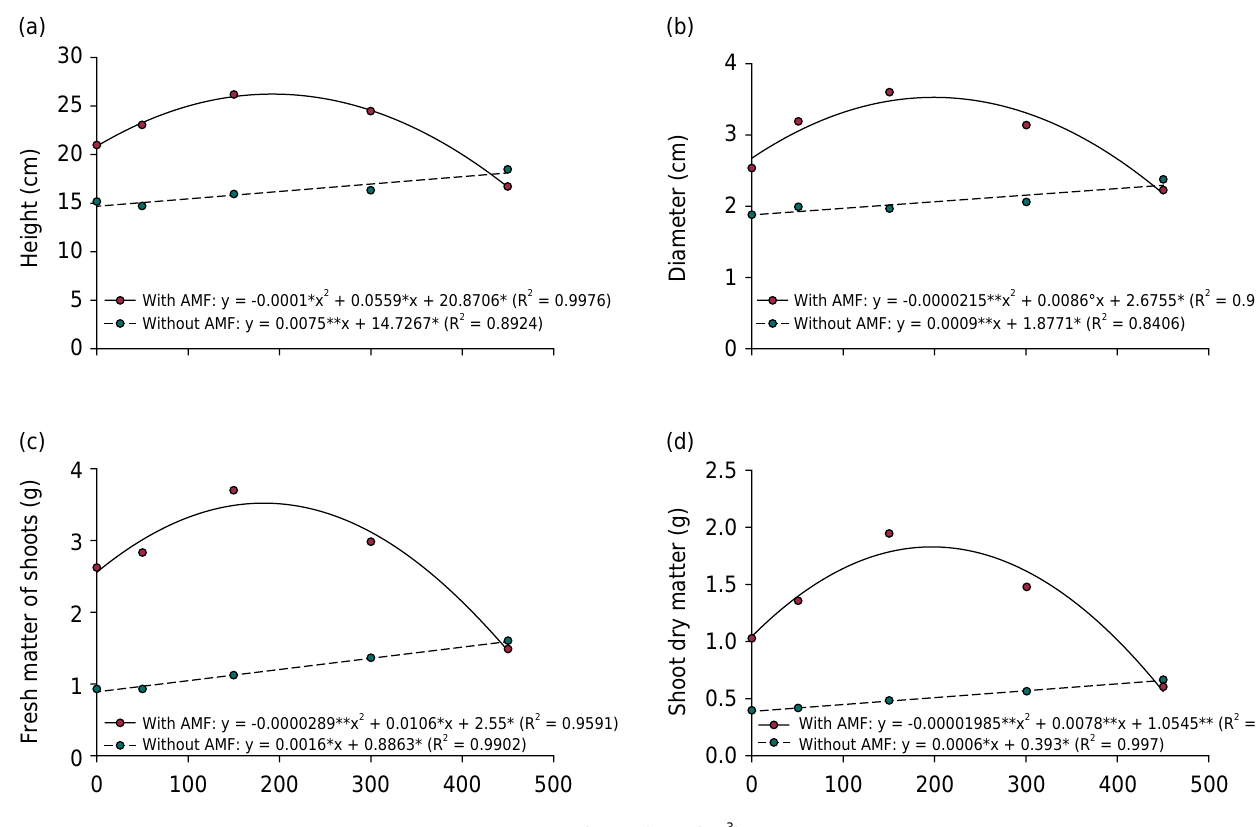
Figure 1. The response of P . reticulata seedlings to different doses of P (0, 50, 150, 300, and 450 mg dm -3 of soil), inoculated or uninoculated with a mix species of arbuscular mycorrhizal fungi ( Claroideoglomus etunicatum , Rhizophagus clarus , Gigaspora albida ), after 90 days of cultivation: (a) height, (b) diameter, (c) fresh, and (d) shoot dry matter. The indicative levels of significance of the regression coefficients in the equations were presented as *, ** and ° corresponding to 0.01, 0.05, and 0.10 probability,